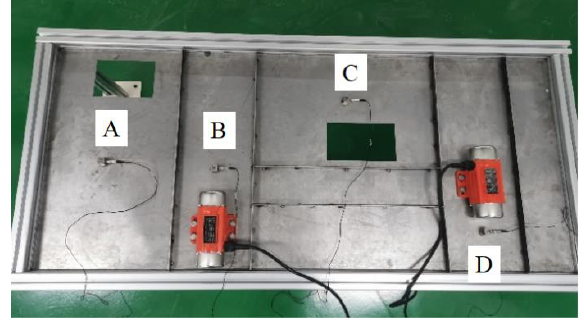
Figure 20. Test layout.